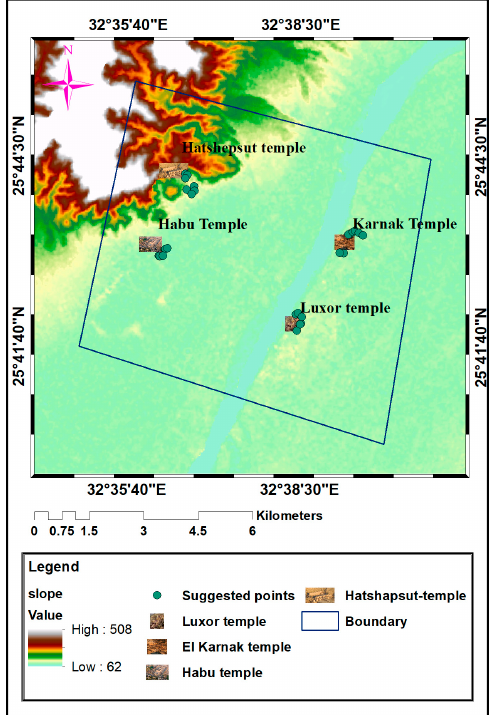
Figure 17. Proposed Points for the recommended trenches around the temples.